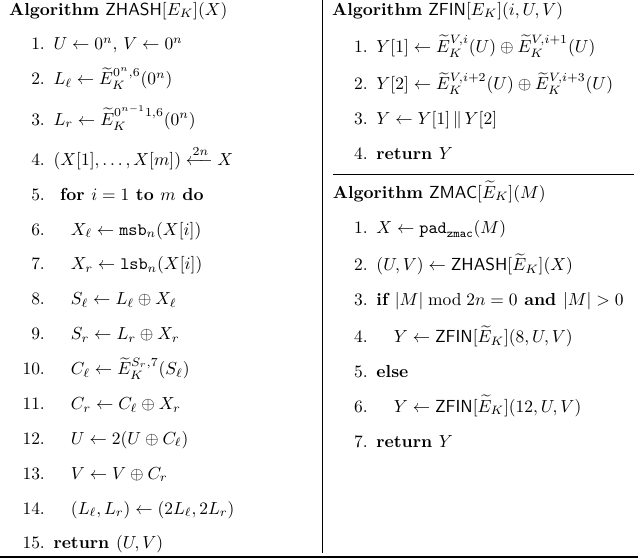
Figure 12: Specification of ZMAC , with a minor modification on domain separation from the original. The padding function pad ( X ) = X when | X | is a positive multiple of 2 n and pad pad zmac